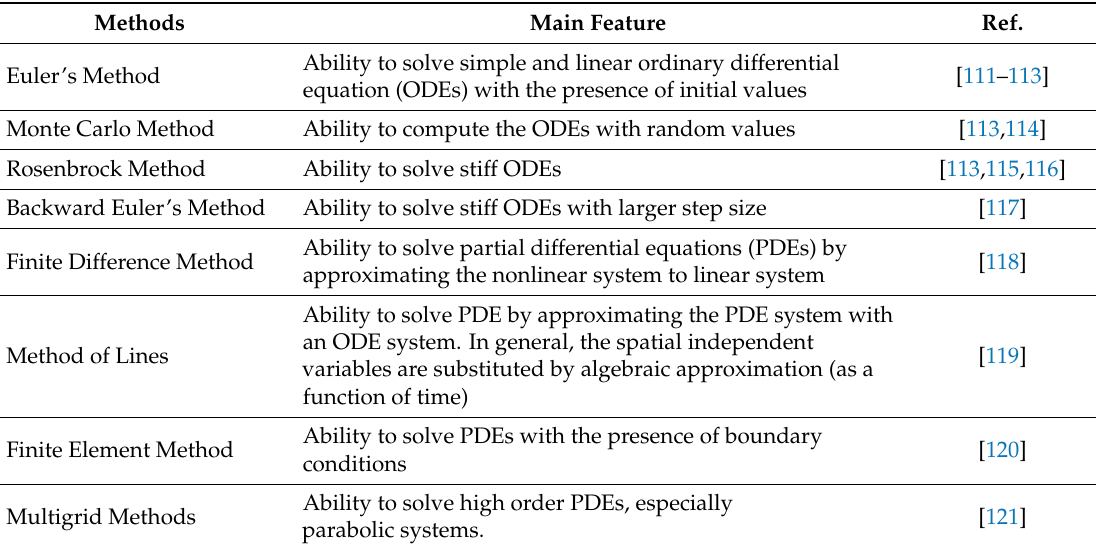
Table 5. Numerical methods for the process